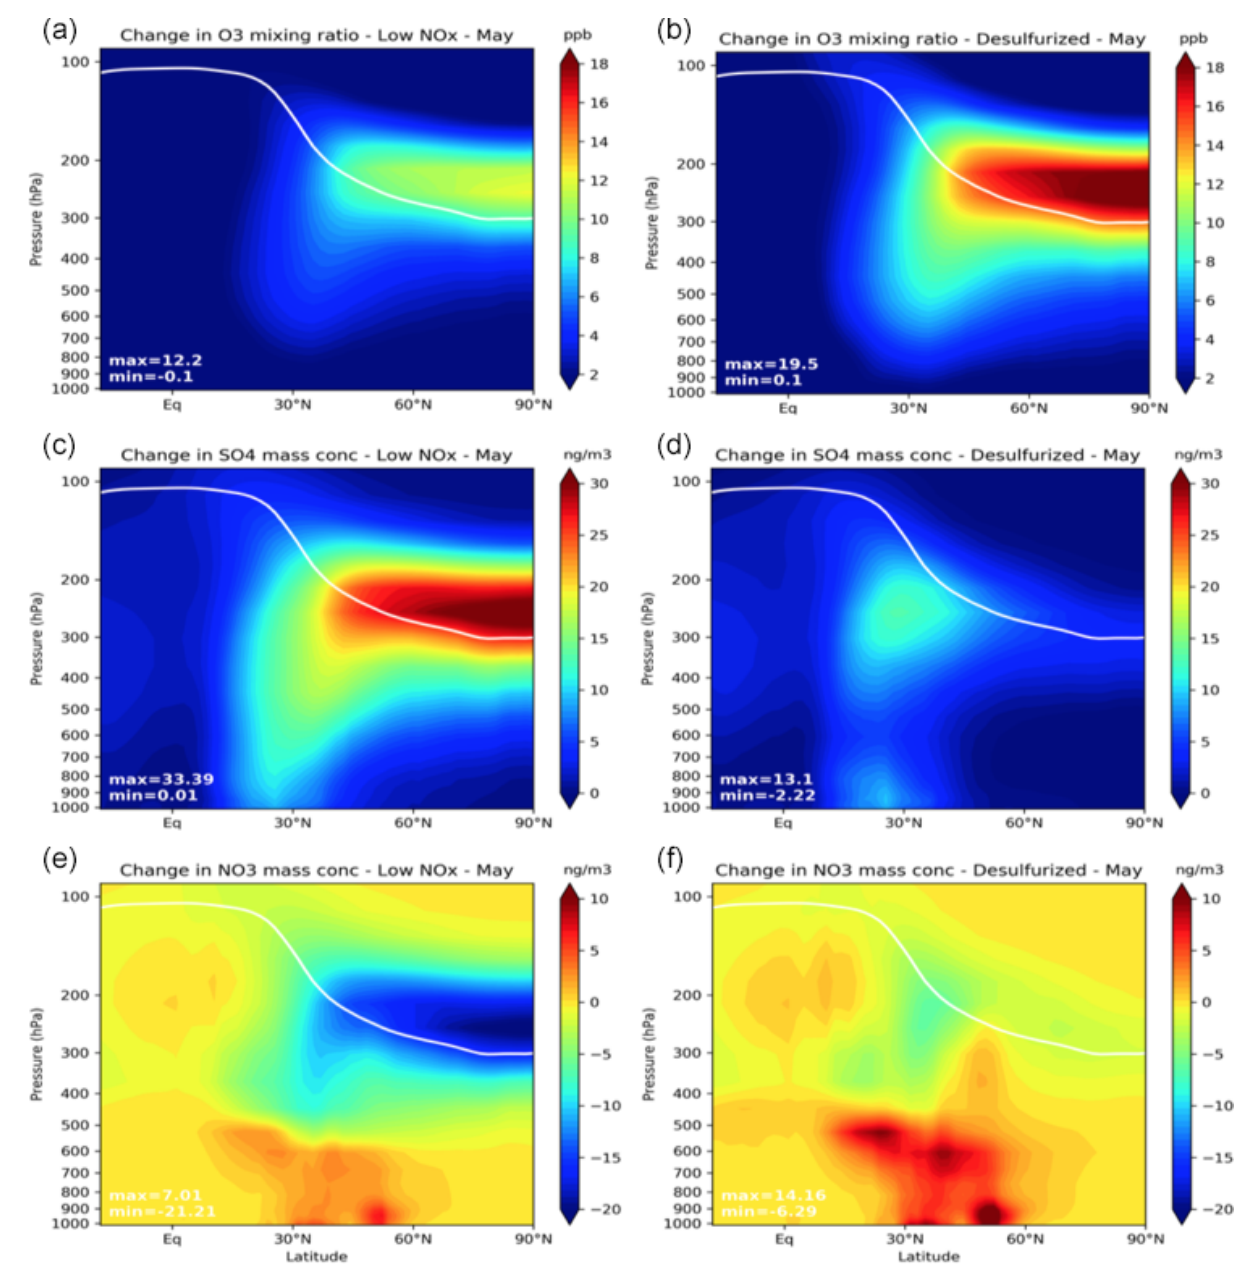
Figure 10. Zonal mean perturbations due to aircraft emissions for May of O 3 (ppbv), SO 4 , and NO 3 (ngm − 3 ) for the LowNOx (a, c, e) and Desulfurized (b, d, f) scenarios. The solid line represents the tropopause